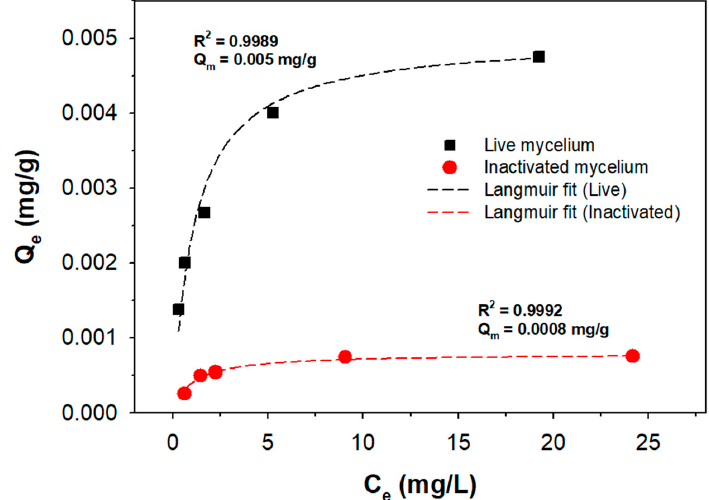
Figure 3. Isotherm for the removal of arsenic. The Langmuir isotherm is shown. The experimental conditions were biomass 60 g / L, contact time 72 h, pH 6.0, temperature 30 ◦ C, and shaking at 160 conditions were biomass 60 g/L, contact time 72 h, pH 6.0, temperature 30 °C, and shaking at 160 rpm.